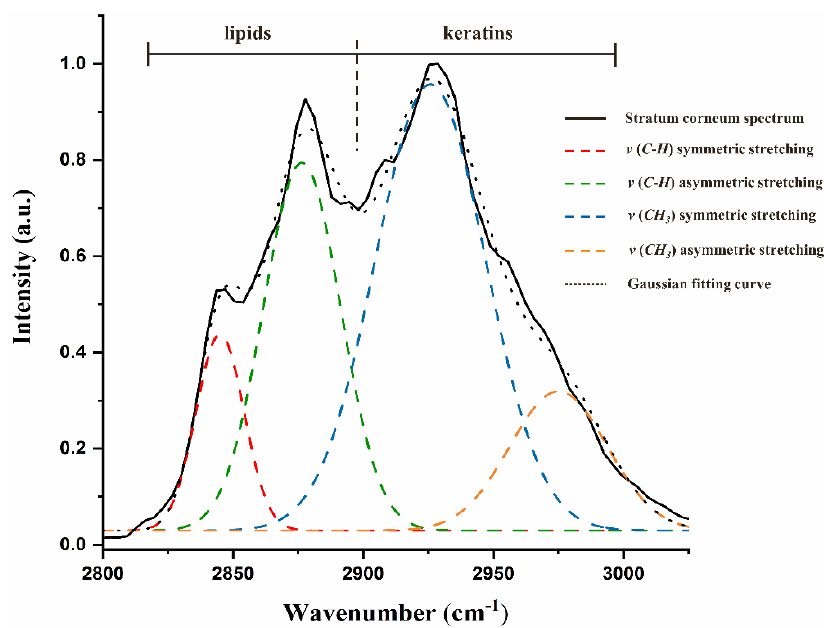
Figure 2. Deconvolution of lipid-keratin peak from skin spectrum by using four Gaussian peaks in high wavenumber region. The assignments were labelled with different colours.